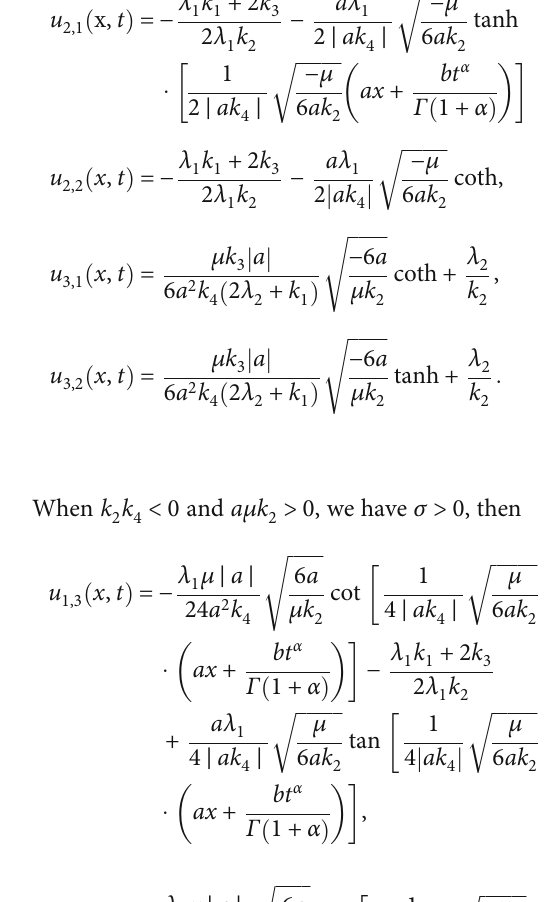
ffiffiffiffiffiffiffiffiffi μ